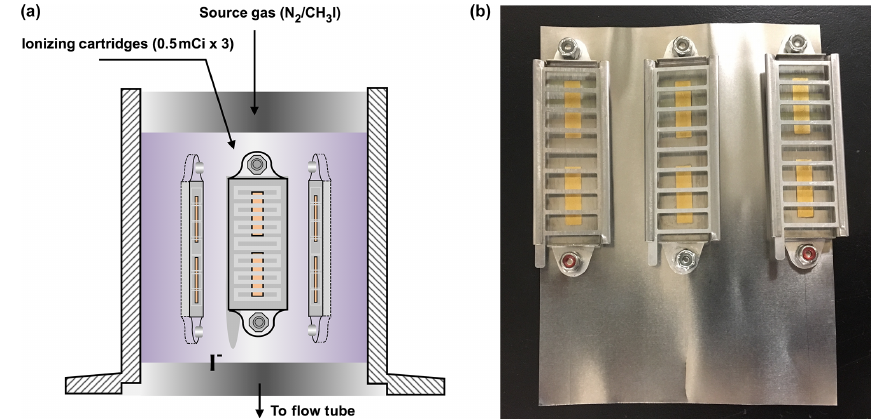
Figure 1. (a) Schematic of the LAS with three antistatic ionizing cartridges are placed in a standard QF-40 nipple. (b) Photograph of the 210 Po cartridges mounted on a stainless-steel foil.